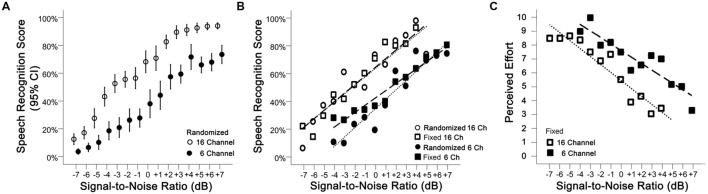
(A) Performance-intensity functions (mean plus 95% confidence intervals) are shown for the 16-channel (open circles) and 6-channel (closed circles) vocoded sentences measured during the physiological test session where SNRs were randomized. (B) Performance-intensity functions across the behavioral (squares) and physiological (circles) test sessions are very similar. (C) Mean effort ratings for 16-channel and 6-channel vocoded material measured in the behavioral test session.